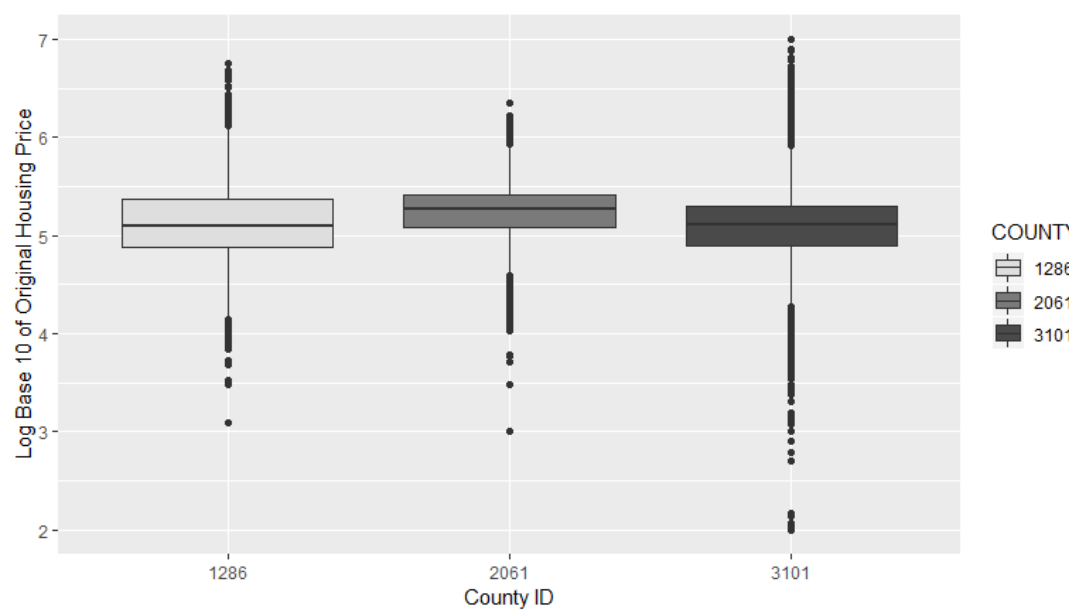
Figure 3. Boxplot of Housing